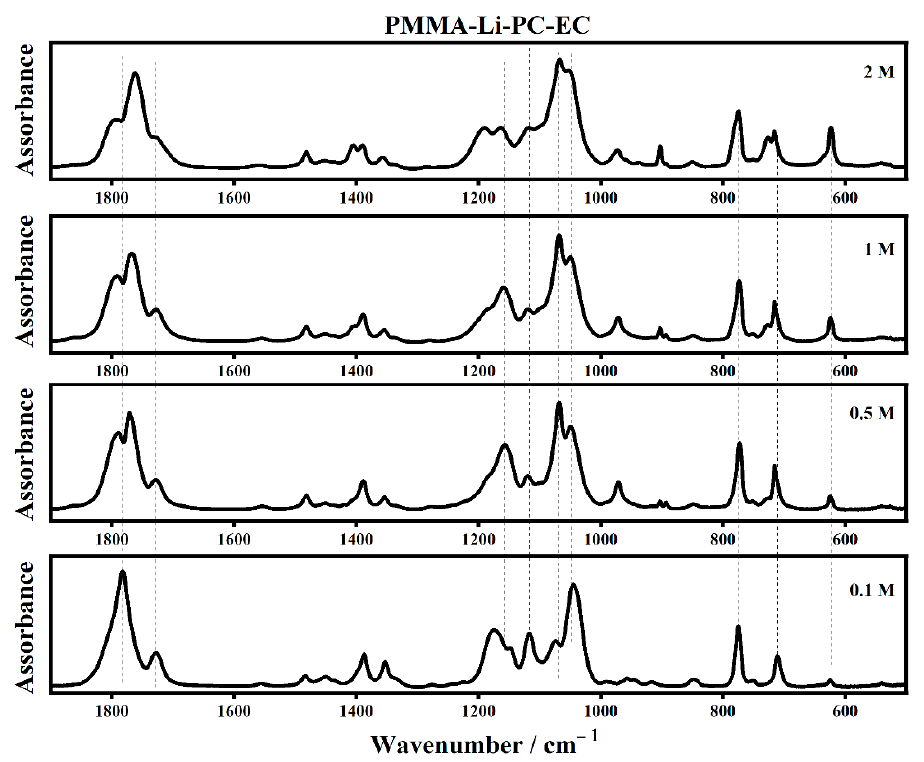
Figure 4. The IR spectra of PMMA-Li-PC-EC for different salt concentrations in the frequency range between 500 cm − 1 and 1900 cm − 1 .